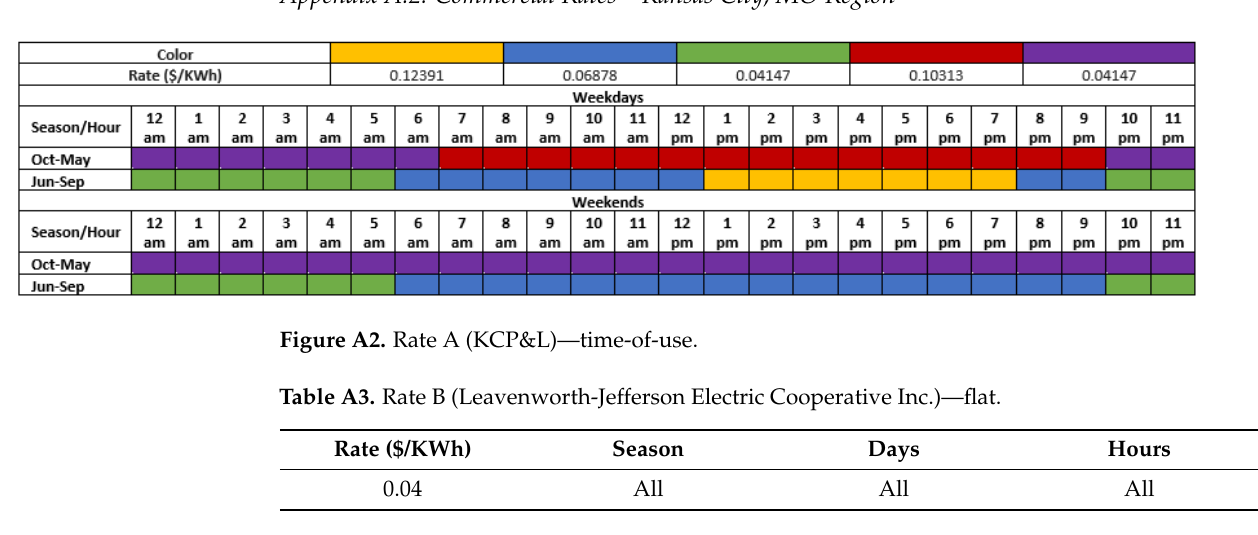
Table A2. USBIA—San Carlos Project—tiered.